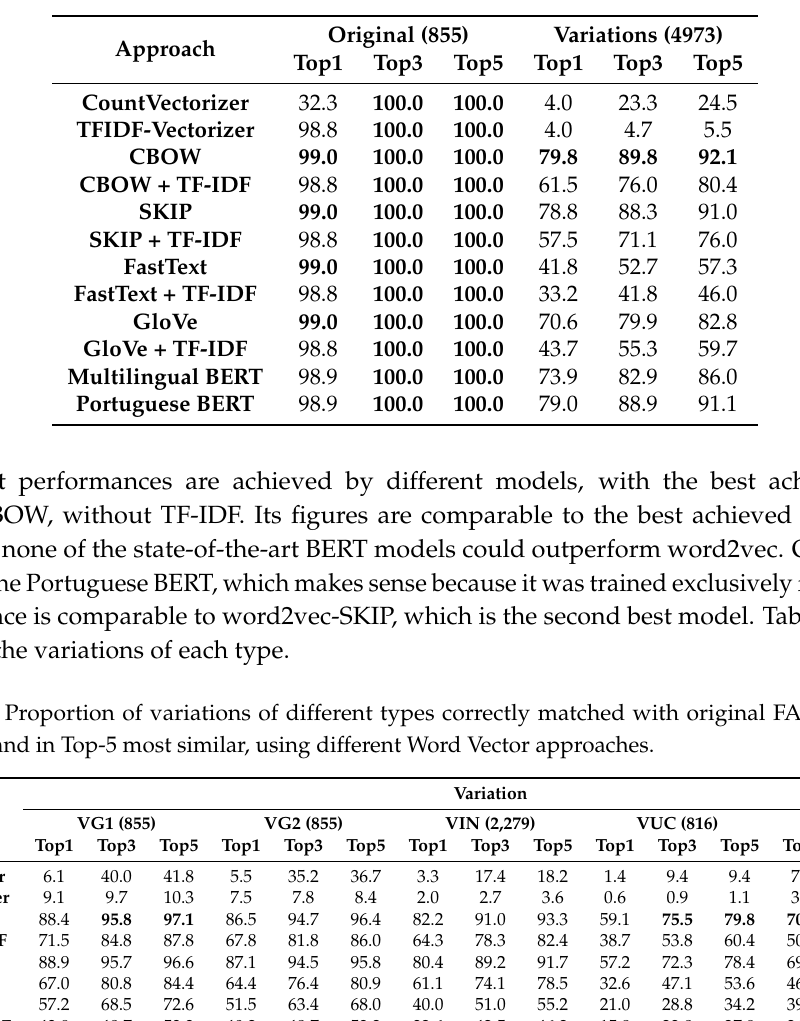
Table 5. Proportion of original questions and variations correctly matched with original FAQs (Top1), in Top-3 and in Top-5 most similar, using different Word Vector approaches.